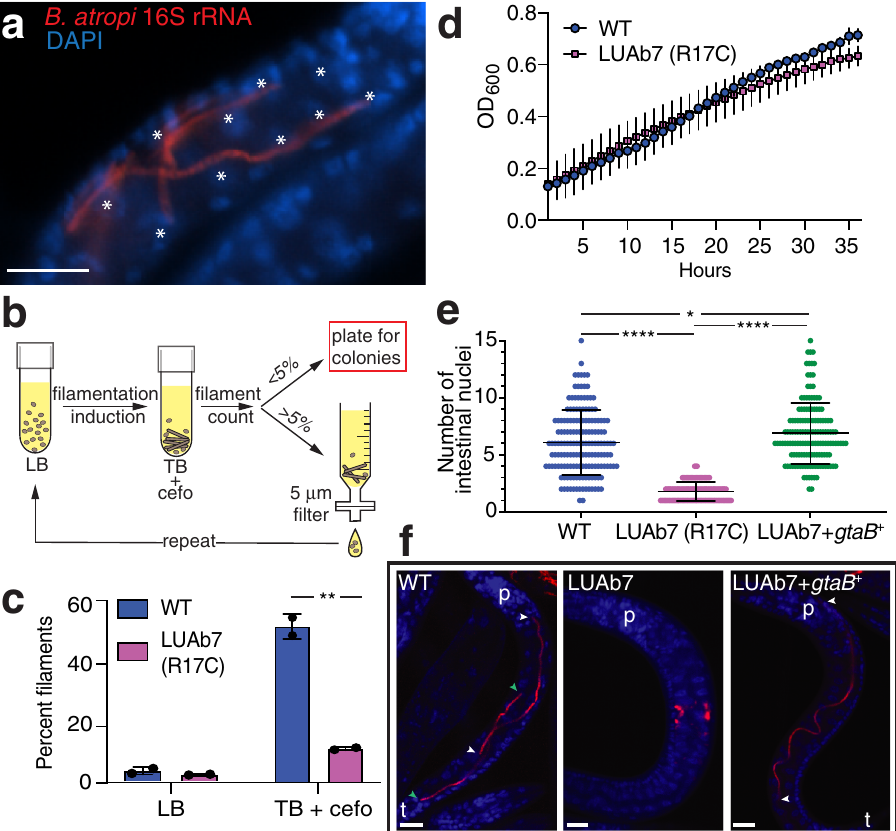
Fig. 4 B. atropi fi laments invade multiple intestinal cells. a Filaments of B. atropi in a larval O. tipulae animal with host nuclei indicated by asterisks. b Schematic for selection of fi lamentation mutants. Filamentation was induced with TB + cefotaxime and counted for percent population with fi laments, with >5% resulting in fi ltration followed by a repeat of induction and <5% resulting in plating to isolate single colonies. c Growth of B. atropi in LB or TB + cefotaxime, with percent fi laments counted after 48 h at 32 °C. Bar graphs are presented with means and error bars represent SD. Each point represents an independent experiment, p = 0.0054 (**) by two-tailed t -test. d B. atropi strains grown in LB at 32 °C for 36 h with OD 600 taken every hour. e Quanti fi cation of B. atropi infection in vivo by the number of intestinal nuclei that a single fi lament or contiguous infection passes along on the anterior- posterior axis. Results are from n = 161 (WT), 129 (LUAb7), and 144 (LUAb7 + gtaB + ) infectious events from a total of 30 animals per group examined over 2 independent experiments, p < 0.0001 (****) or p = 0.014 (*) by Mann – Whitney two-tailed t -test. f Representative images from e , with fi lament ends (color-match e d arrowheads), the pharynx (p) and tail (t) indicated. Scale bars are 10 μ